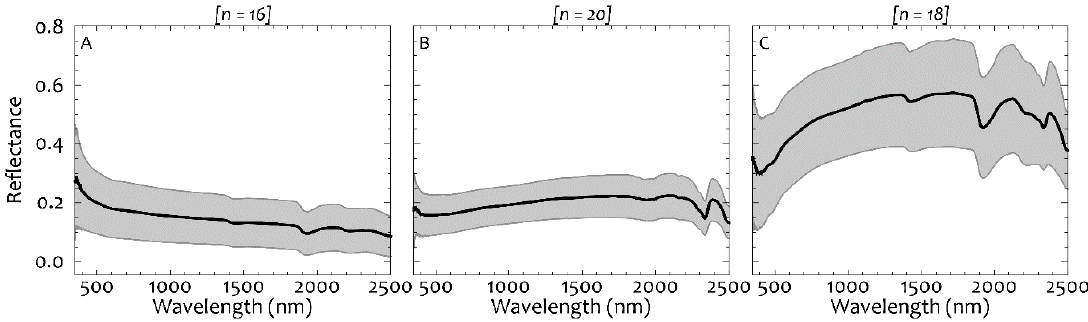
Figure 7. Reflectance spectroscopy results of ( A ) chert, ( B ) limestone, and ( C ) tripolite samples. Solid black lines depict the mean spectrum of each lithology whereas gray areas show ± 2 σ around the mean, accounting for 95.45% variability. The number of samples analyzed is indicated by [n].